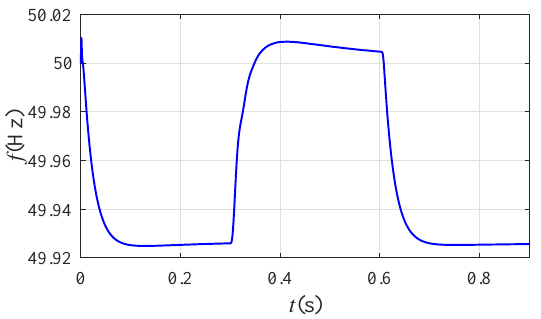
Figure 7. Variation of frequency under ACB control strategy.